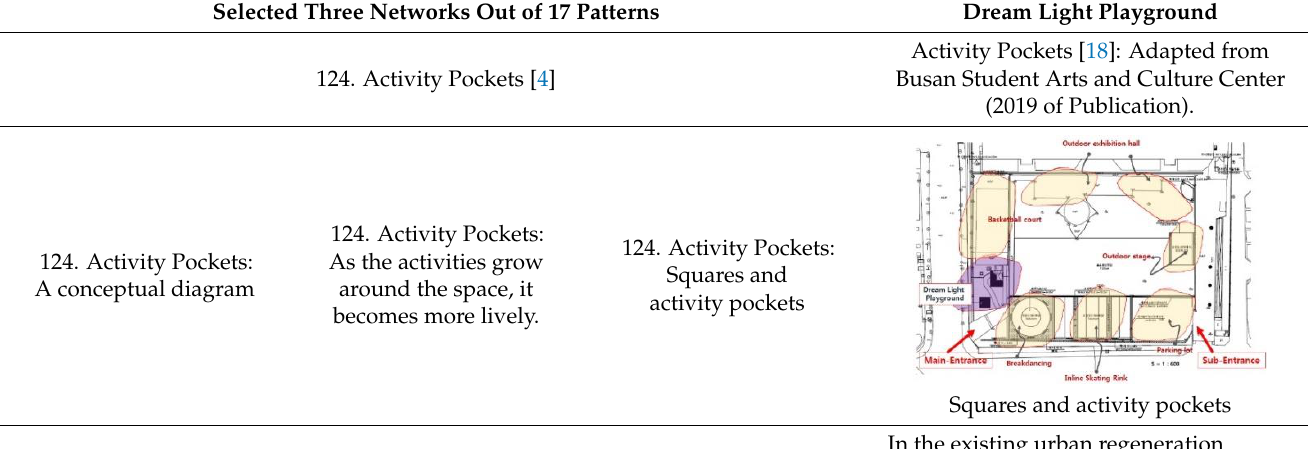
Table 4. Media experience type classification: Select 3 pattern languages from 16 pattern languages and compare and analyze them with the actual project site.